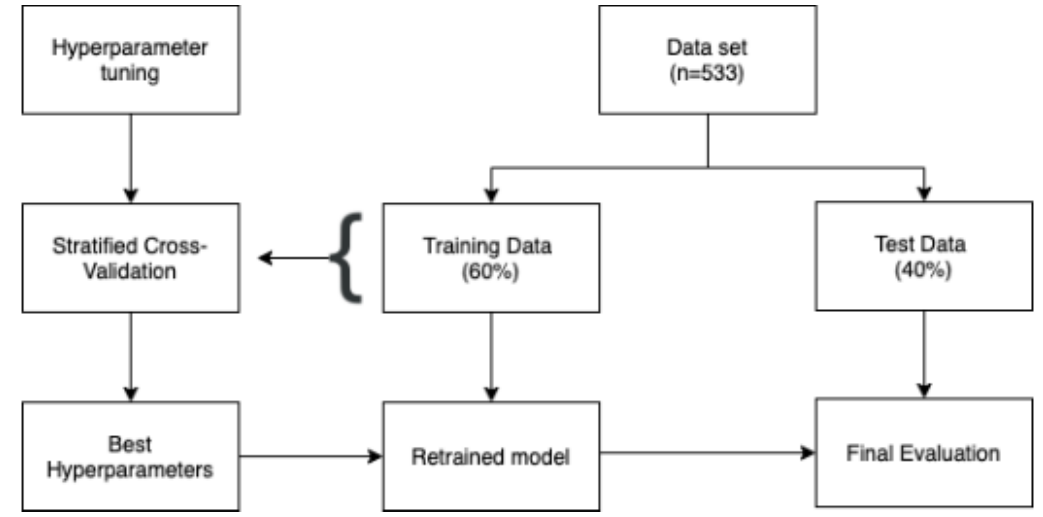
Figure 3. Overview of data set partitioning and model